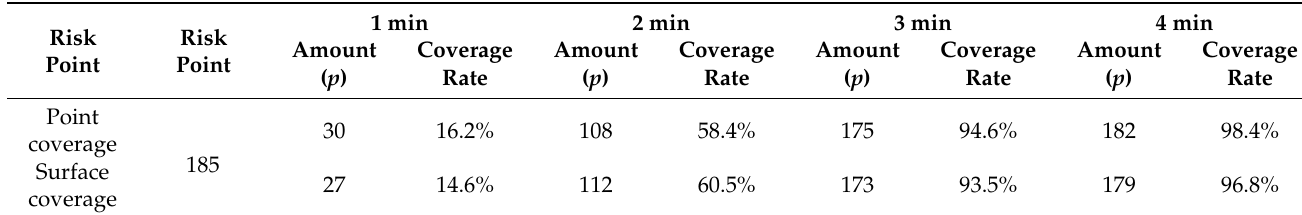
Table 7. Coverage at each